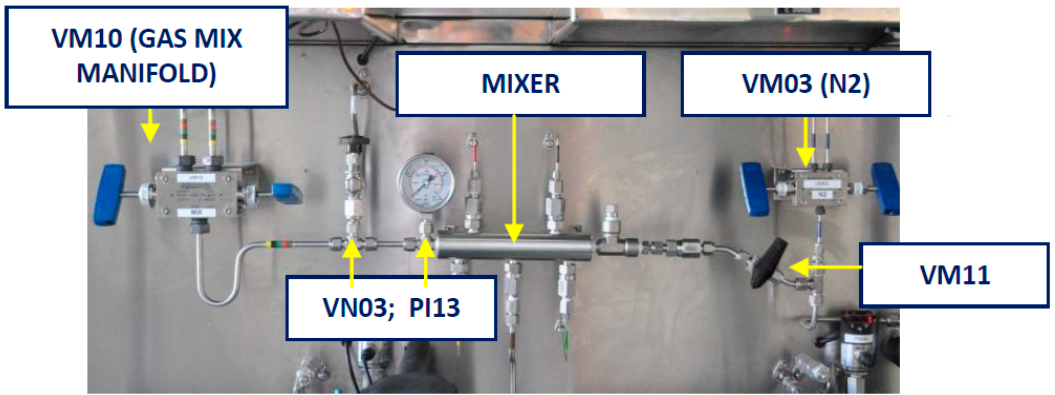
Figure 7. Gas and liquid mixer system. VM10—gas mixture manifold for gas feed to the reactors; VN03—mixer vent valve; PI13—mixer manometer; VM03—nitrogen manifold for pure nitrogen feed to the reactor; VM11—nitrogen valve that connects the nitrogen line with the mixer.